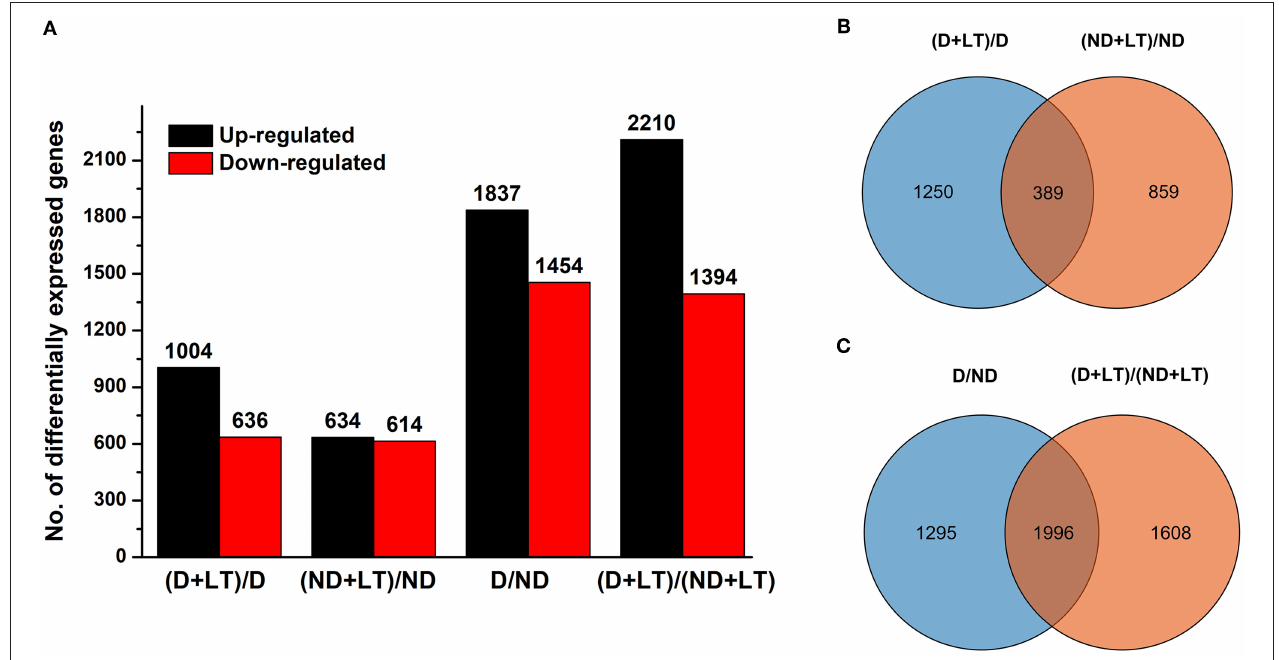
FIGURE 2 | The bar chart (A) and Venn diagram (B,C) of differentially expressed genes (DEGs) in dormancy (D) and non-dormancy (ND) alfalfa genotype under LT conditions.